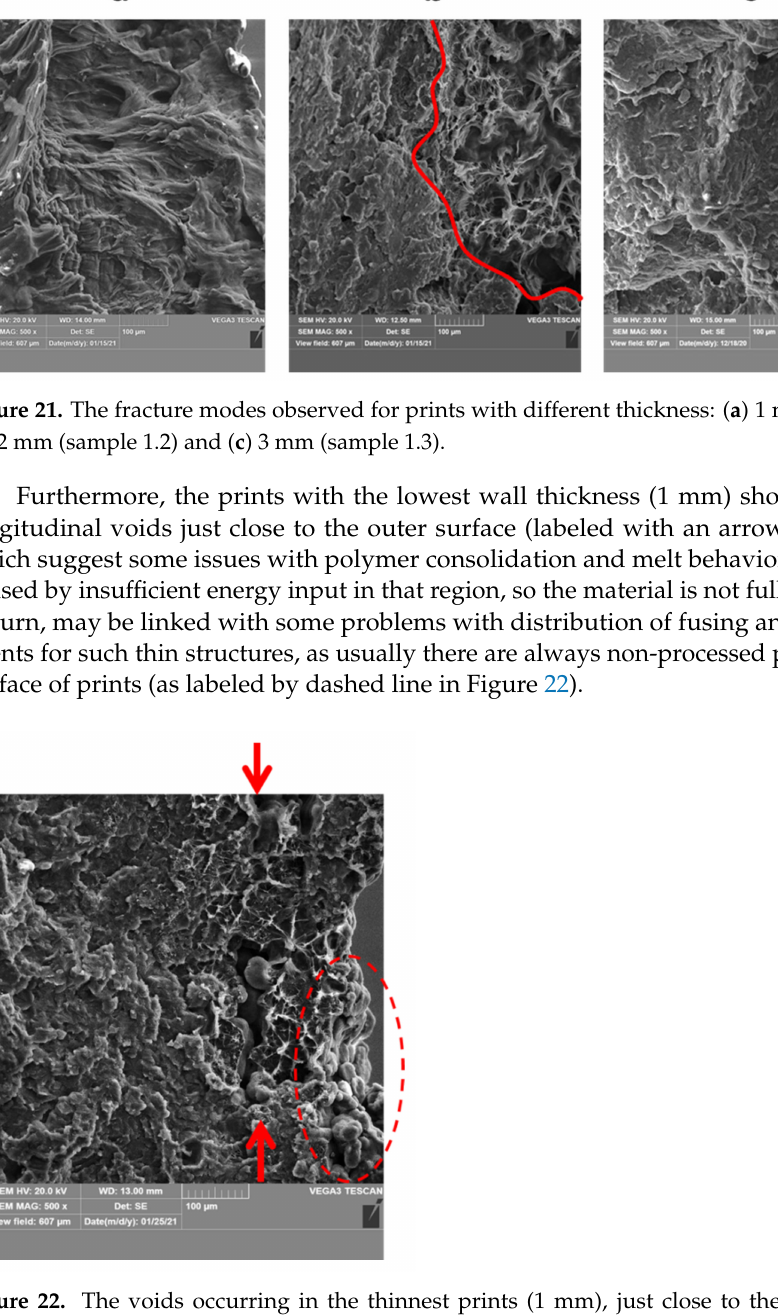
Figure 22. The voids occurring in the thinnest prints (1 mm), just close to the sample surface (sample